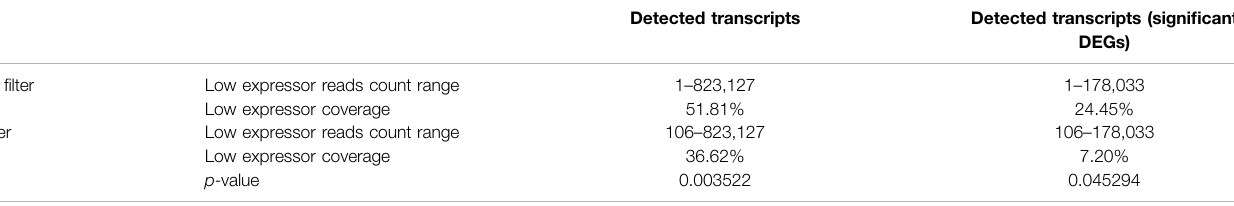
TABLE 4 | Coverage of low expressors is reduced in bulk-seq when scRNA-seq fi lters apply. Low expressor reads counts are an average across all control samples (CD, CI, CB).